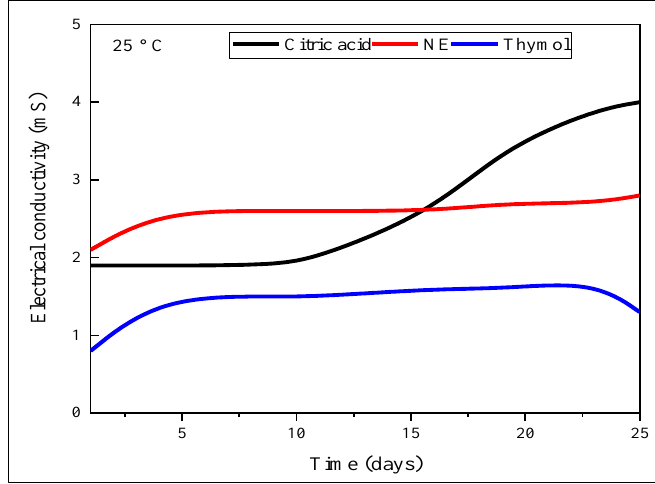
Figure 6: Electrical conductivity (mS).